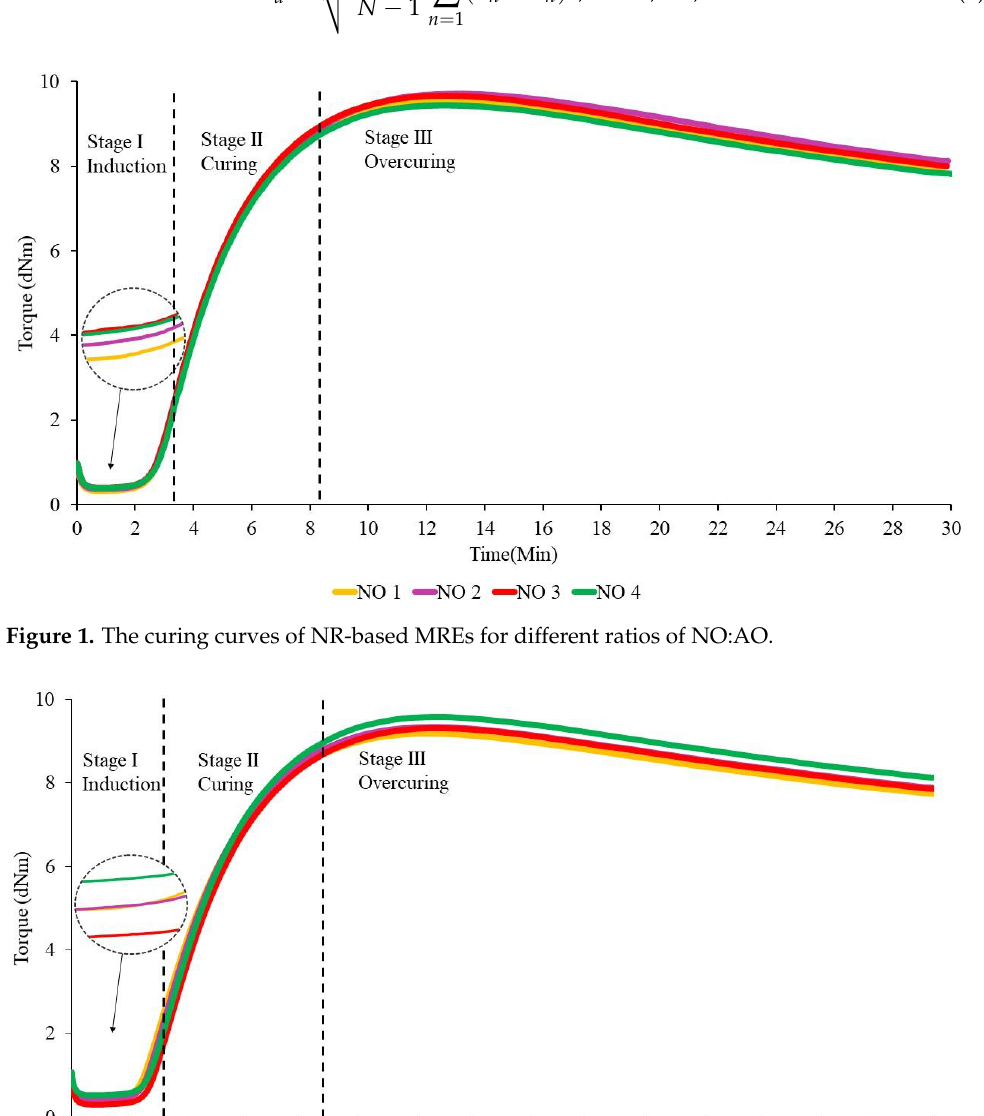
Figure 3. The curing curves of NR-based MREs for different ratios of PO:AO. The values of scorch time (t s1 ), cure time (t 90 ), minimum torque (M L ), maximum torque (M H ), and torque value difference (ΔM) that were obtained from curing curves of different ratios of PBOs are summarized in Table 4 Table 5 Table 6. The moving 𝑆 𝑑 for